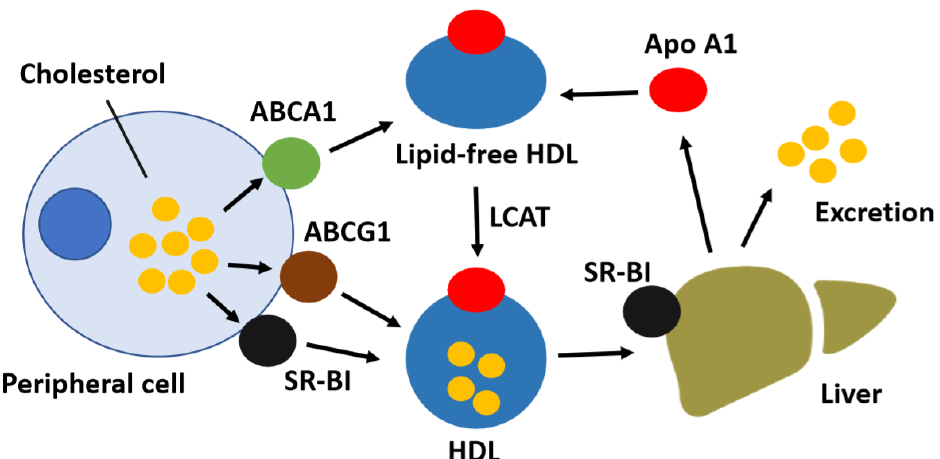
Figure 1. Schematic diagram of reverse cholesterol transport. Lipid-poor Apolipoprotein (Apo) A1 acquires free cholesterol from peripheral cells via ATP binding cassette transporter (ABC) A1, whereas the ABCG1 and scavenger receptor BI (SR-BI) transporters facilitate cholesterol efflux to high-density lipoprotein (HDL) particles. Free cholesterol is esterified to cholesteryl esters within nascent HDL particles by lecithin-cholesterol acyltransferase (LCAT), thereby generating mature HDL. The liver selectively takes up HDL-associated cholesteryl esters via SR-BI and excretes HDL-derived cholesterol into the bile as free cholesterol or as bile acids after conversion.